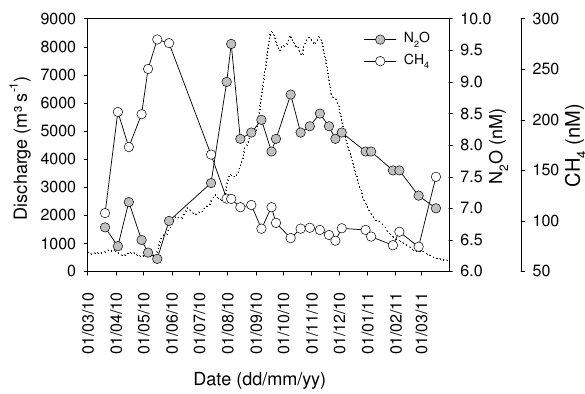
Fig. 8. Seasonal variations of daily discharge (dotted line) and con- centrations of dissolved CH 4 (open symbols) and N 2 O (grey sym- bols), in the Oubangui River at Bangui between March 2010 and March 2011.